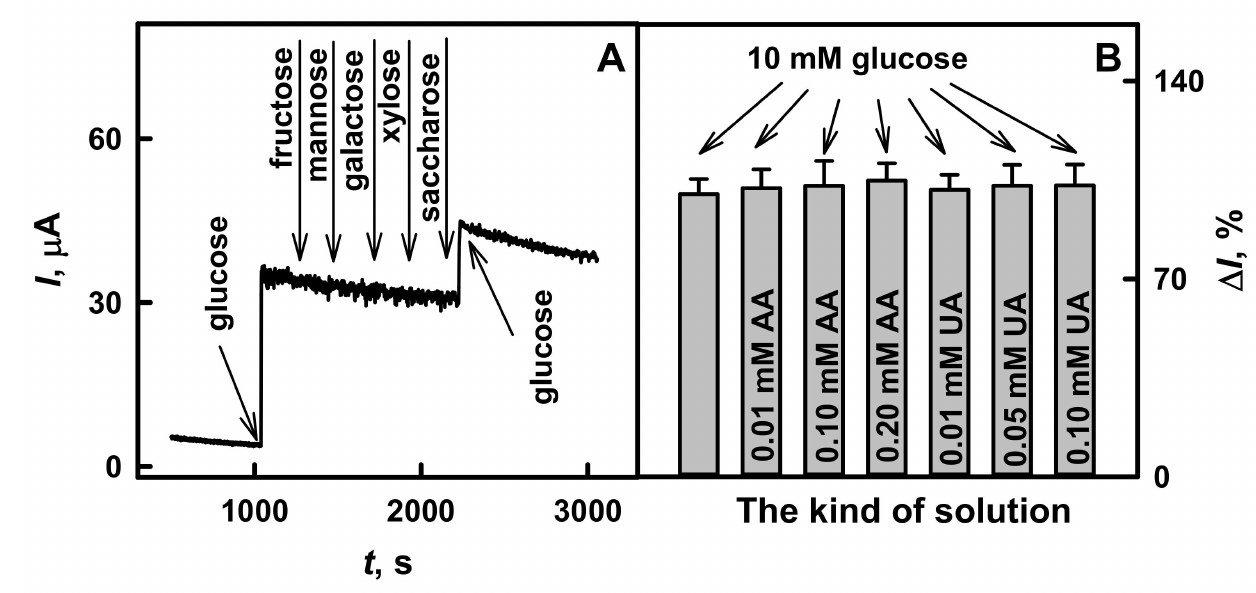
Figure 7. The influence of interfering species on the current response of glucose biosensor based on the GR/PANI- AuNPs (6 nm) -GOx/GOx electrode. Conditions: ( A ) amperogram registered in 10 × diluted serum sample after the addition of 10.0 mmol L − 1 glucose and 1.00 mmol L − 1 of fructose, mannose, galactose, xylose or saccharose, ( B ) the diagram of registered current response in 10 × diluted serum sample after the addition of 10.0 mmol L − 1 glucose (first grey column without marking inside); of 10.0 mmol L − 1 glucose with 0.01, 0.10 or 0.20 mmol L − 1 of AA; of 10.0 mmol L − 1 glucose with 0.01, 0.05 or 0.10 mmol L − 1 of UA. Amperometric responses were registered in a 10 × diluted sample of serum in the presence of 6 mmol L − 1